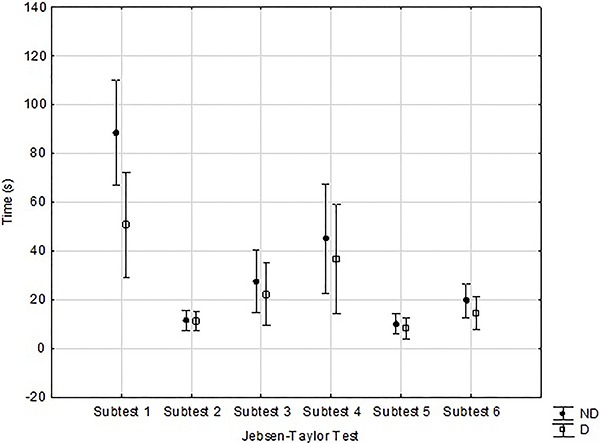
Repeated measures analysis of variance reported as means and 95% confidence intervals for each subtest of Jebsen-Taylor Test, comparing non-dominant (ND) and dominant (D) upper limbs. There was an interaction between subtest and limb (P<0.001) and post hoc Tukey tests showed a significant difference between ND and D upper limbs (P<0.001) only in subtest 1.